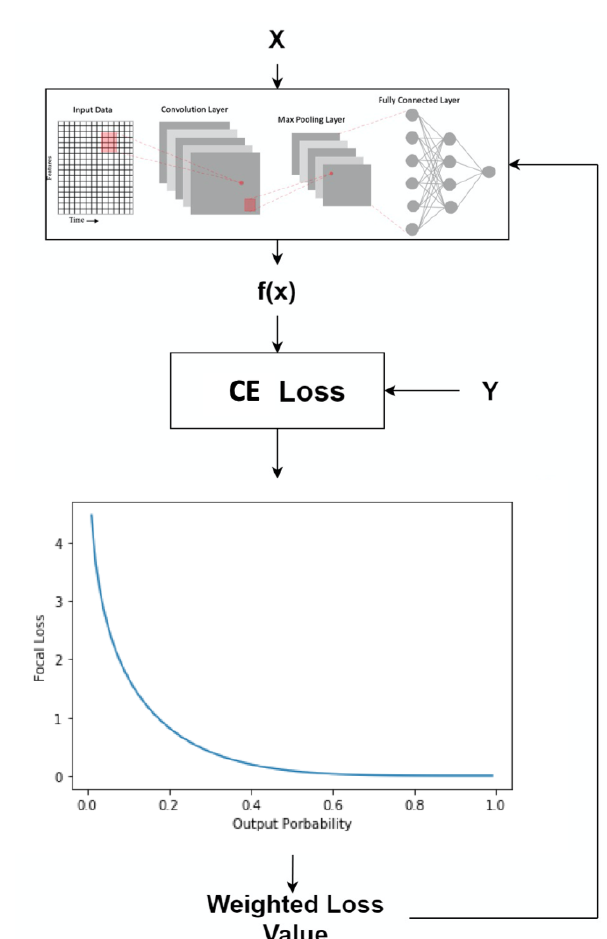
Figure 9. The output f ( x ) from the deep learning model and the ground truth Y are used to calculate the cross entropy (CE) loss for one instance. The CE is then combined with the weighted function to produce the weight that will be used to dynamically adjust the loss